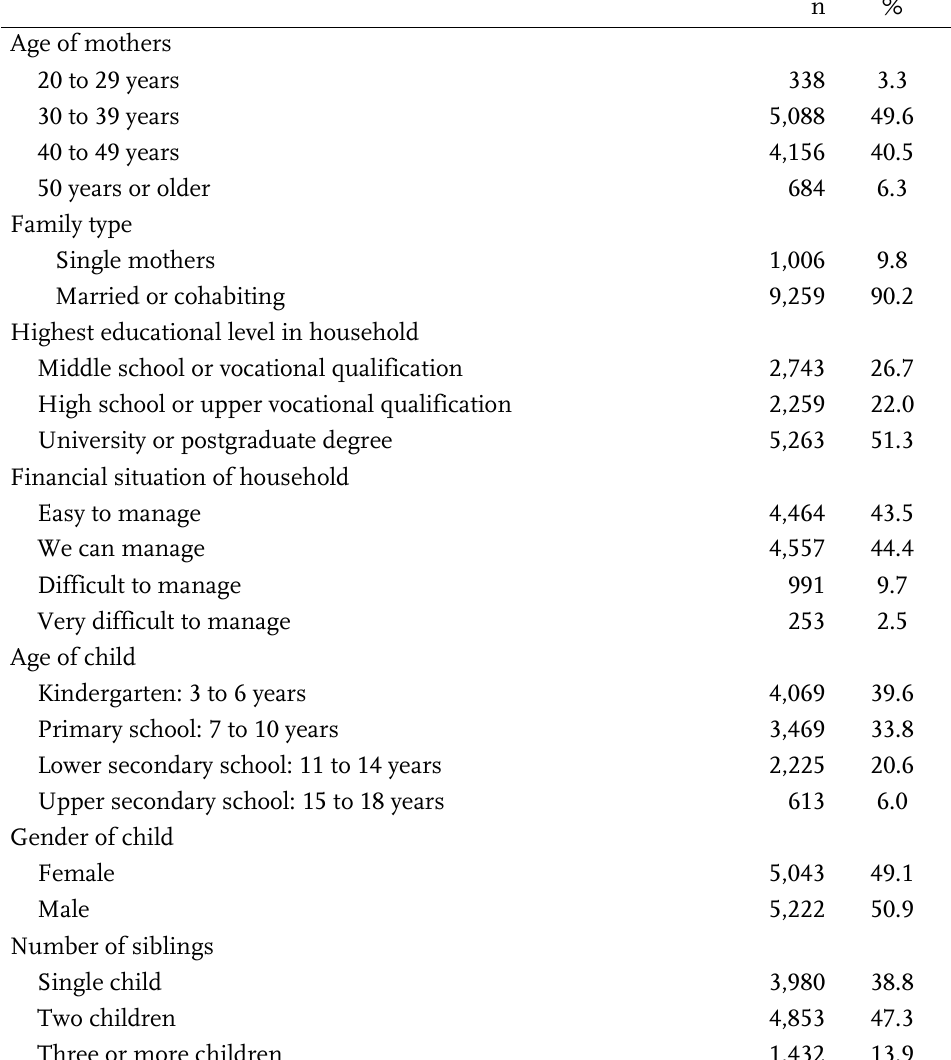
Table 1 : Sociodemographic characteristics of mothers, families, and children